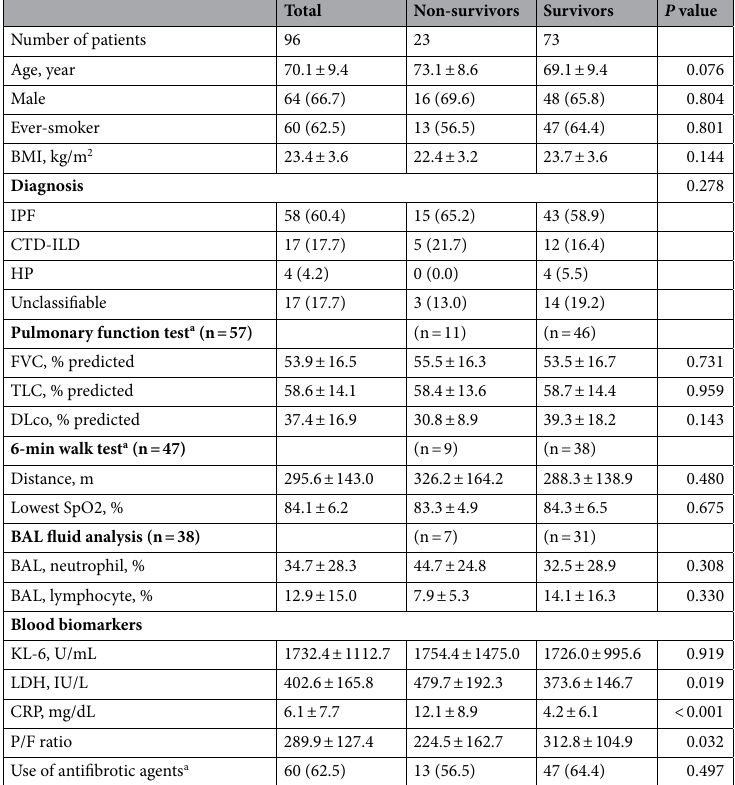
Table 1. Comparison of the baseline characteristics between non-survivors and survivors during hospitalization. Data are presented as mean ± standard deviation or number (%). BMI body mass index, IPF idiopathic pulmonary fibrosis, CTD connective tissue disease, ILD interstitial lung disease, HP hypersensitivity pneumonitis, FVC forced vital capacity, TLC total lung capacity, DLco diffusing capacity of the lung for carbon monoxide, BAL bronchoalveolar lavage, KL-6 Krebs von den Lungen-6, LDH lactate dehydrogenase, CRP C-reactive protein, P/F ratio ratio of partial pressure of oxygen to the fraction of inspiratory oxygen. a At the time of